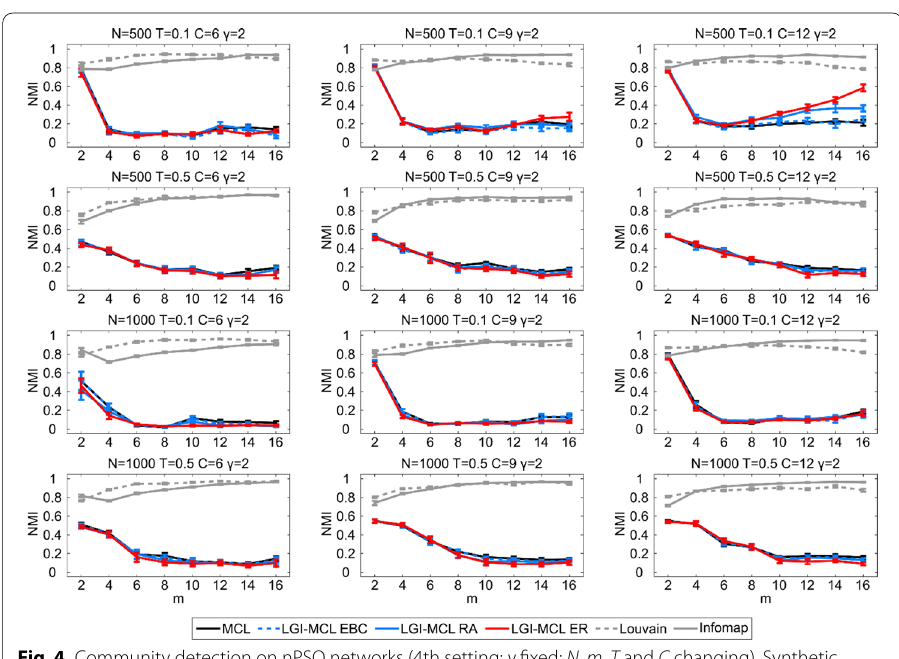
Fig. 4 Community detection on nPSO networks (4th setting: γ fixed; N , m , T and C changing). Synthetic networks have been generated using the nPSO model with parameters N [500, 1000] (network size) γ 2 = = (power-law degree distribution exponent), m [2, 4, 6, 8, 10, 12, 14, 16] (half of average degree), T [0.1, = = 0.5] (temperature, inversely related to the clustering coefficient) and C [6, 9, 12] (number of communities). = For each combination of parameters, 10 networks have been generated. For each network the community detection methods have been executed and the communities detected have been compared to the annotated ones computing the Normalized Mutual Information (NMI). The plots report for each parameter combination the mean NMI and standard error over the random repetitions and show that, at low γ , the MCL performance is close to state of the art methods for low m , whereas it decreases for higher